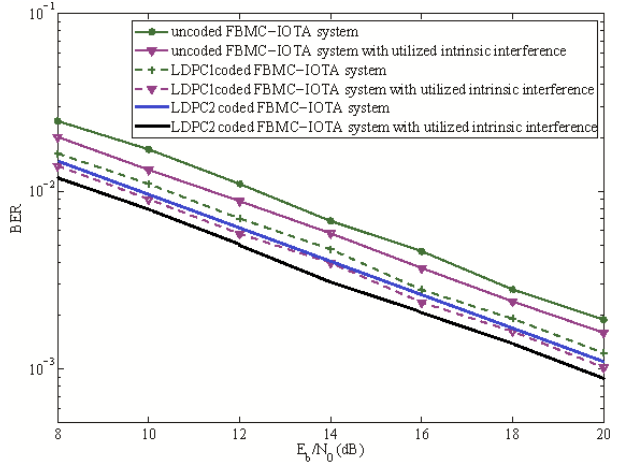
Figure 1. BER performance with perfect channel estimation and